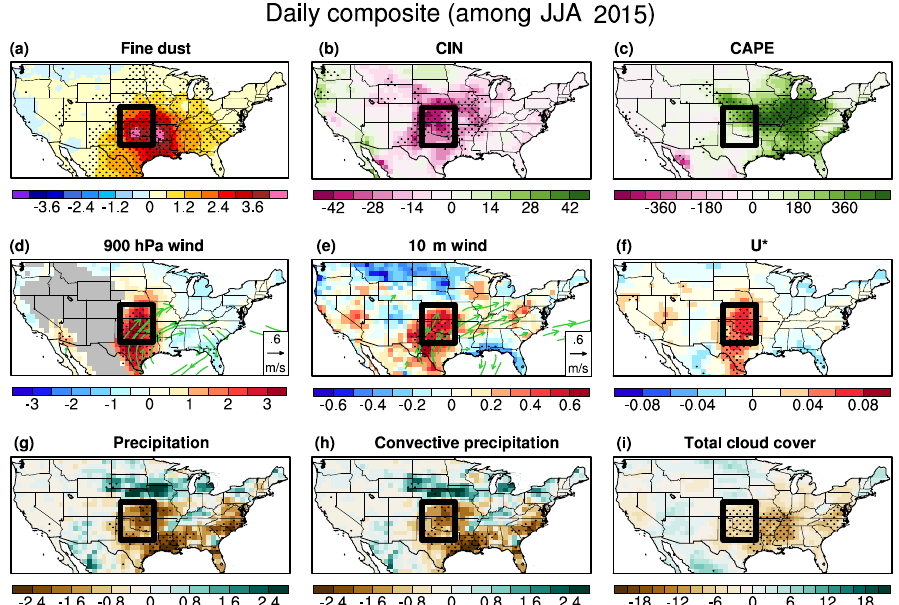
Figure 9. Daily composites of the anomalies of (a) fine dust concentration (µgm − 3 ) , (b) CIN (Jkg − 1 ) , (c) CAPE (Jkg − 1 ) , (d) 900hPa wind speed (ms − 1 ) , (e) 10m wind speed (ms − 1 ) , (f) U ∗ (ms − 1 ) , (g) total precipitation (mmday − 1 ) , (h) convective precipitation (mmday − 1 ) , and (i) total cloud cover (%) during dusty days in JJA from 2002 to 2015. Dotted areas are significant at the 95% confidence level. Shown in panels (d) and (e) are the 900hPa and 10m wind anomalies (green vectors) significant at the 95% confidence level, respectively. Black boxes denote the CGP region.